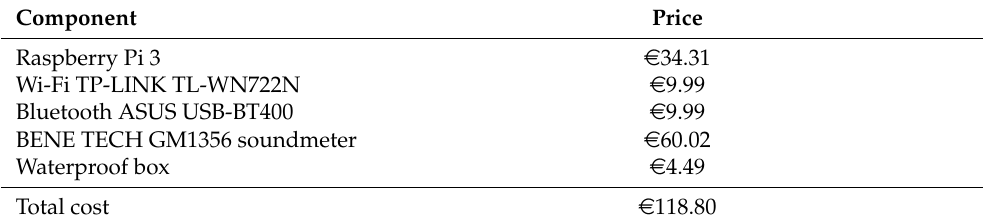
Table 1. Price of the components used to deploy the sensors of the proposed IoT